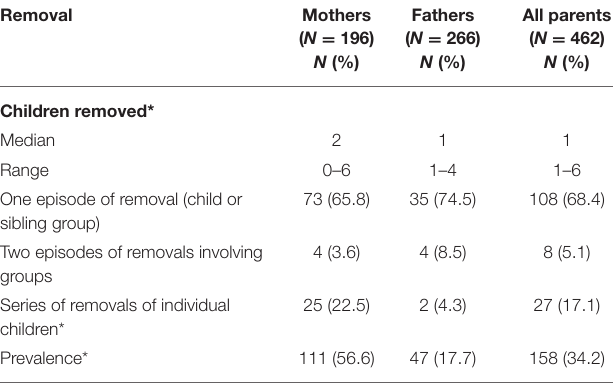
TABLE 2 | Prevalence and patterns of child removal.